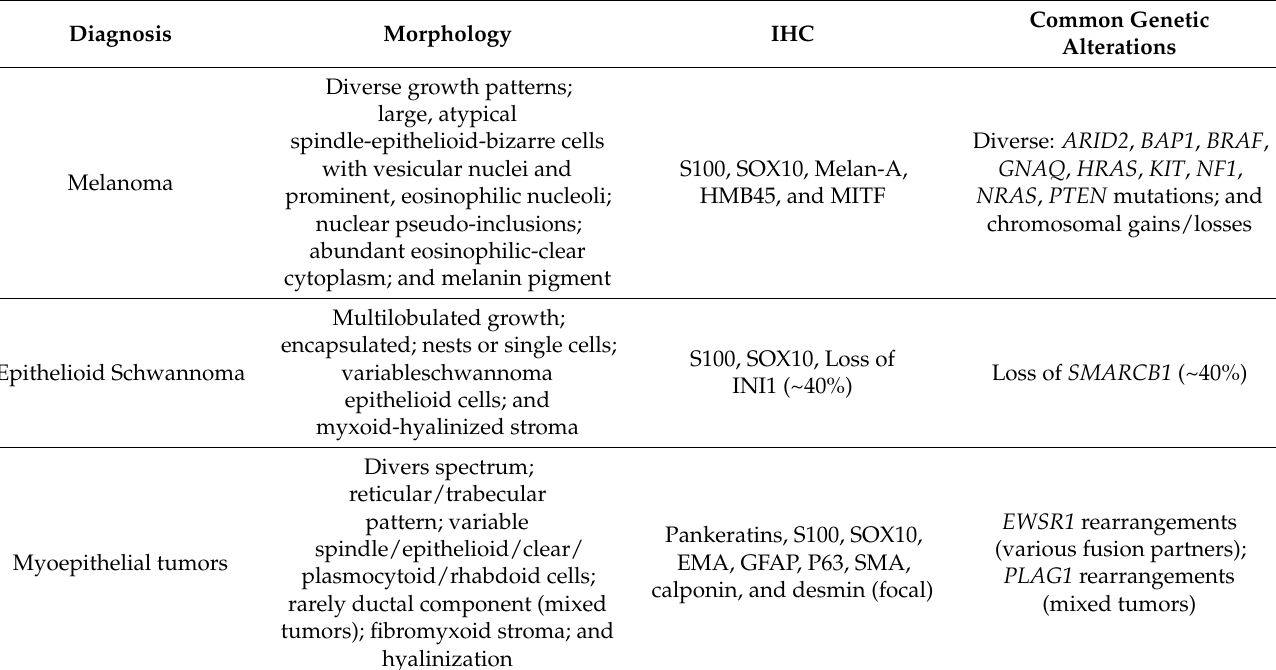
Table 7. Differential diagnoses of